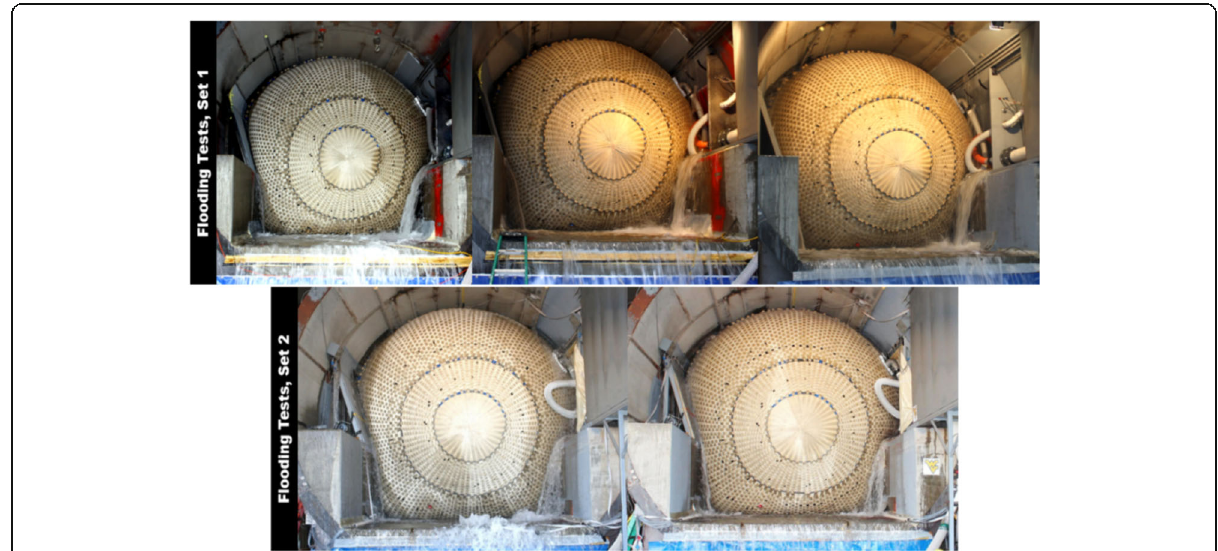
Fig. 13 Phase 2b-ET, full-scale testing, three-layer Vectran plug: Front view of flooding tests carried out for Phase 2b (top row) and Phase 2b-ET (bottom row) [69,